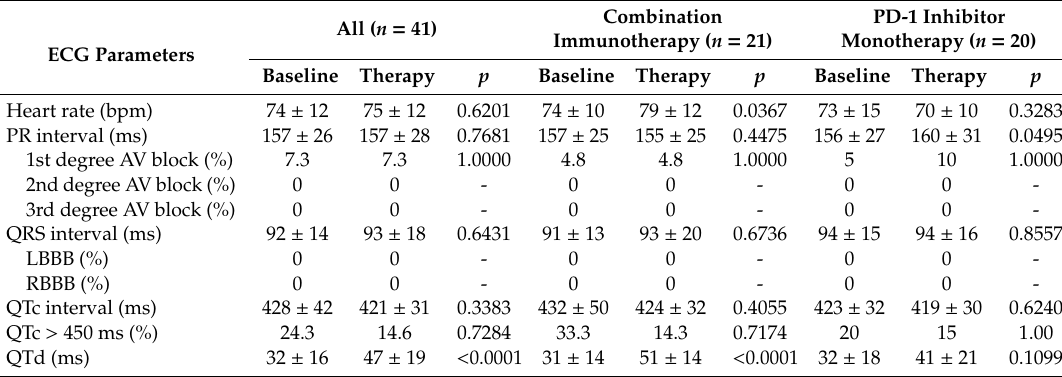
Table 2. Electrocardiogram (ECG)